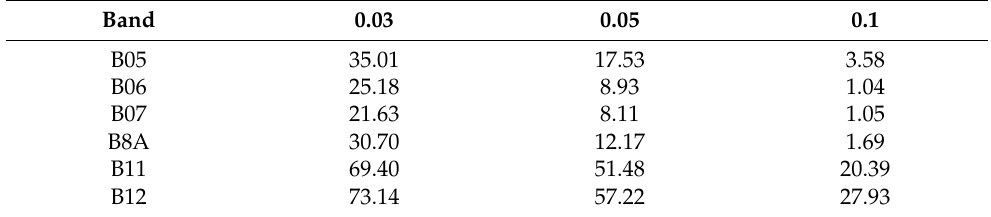
Table 9. Percentage of pixels beyond a given relative error threshold for reflectances in [0.1, 0.25] (L1C).